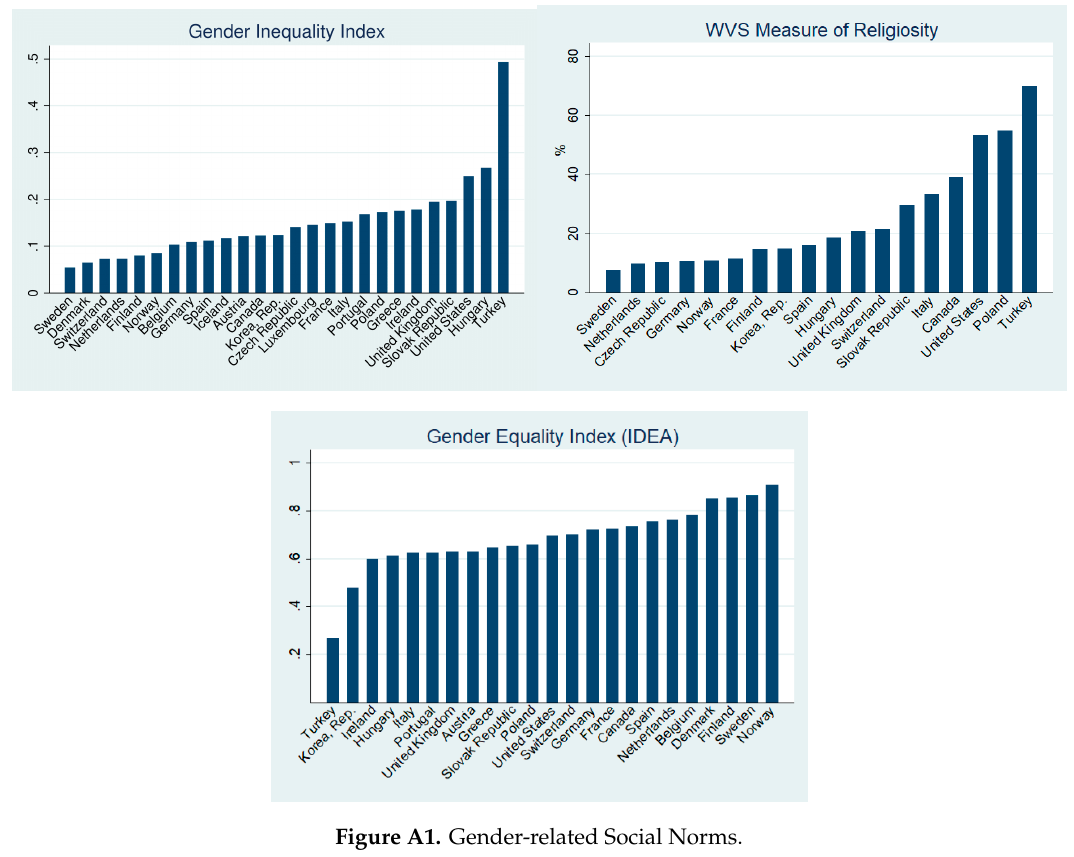
Figure A1. Gender ‐ related Social Norms.